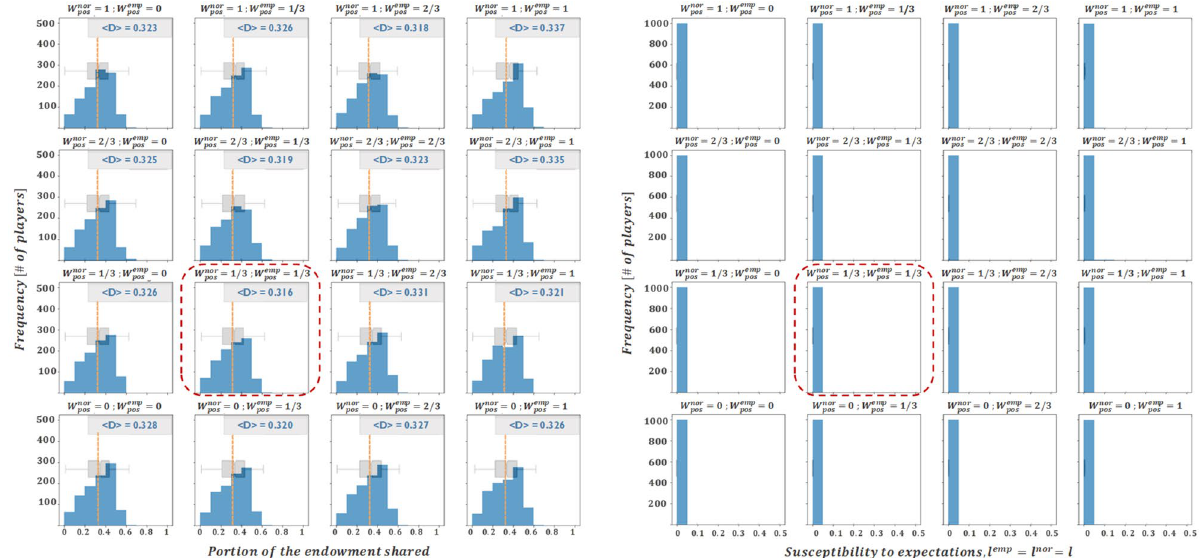
Figure 6. Final averaged distributions of donations and susceptibility profiles for W emp , neg = W nor , neg = 1 and = l emp l nor i , t . Each subplot represents a given combination of i , t columns,